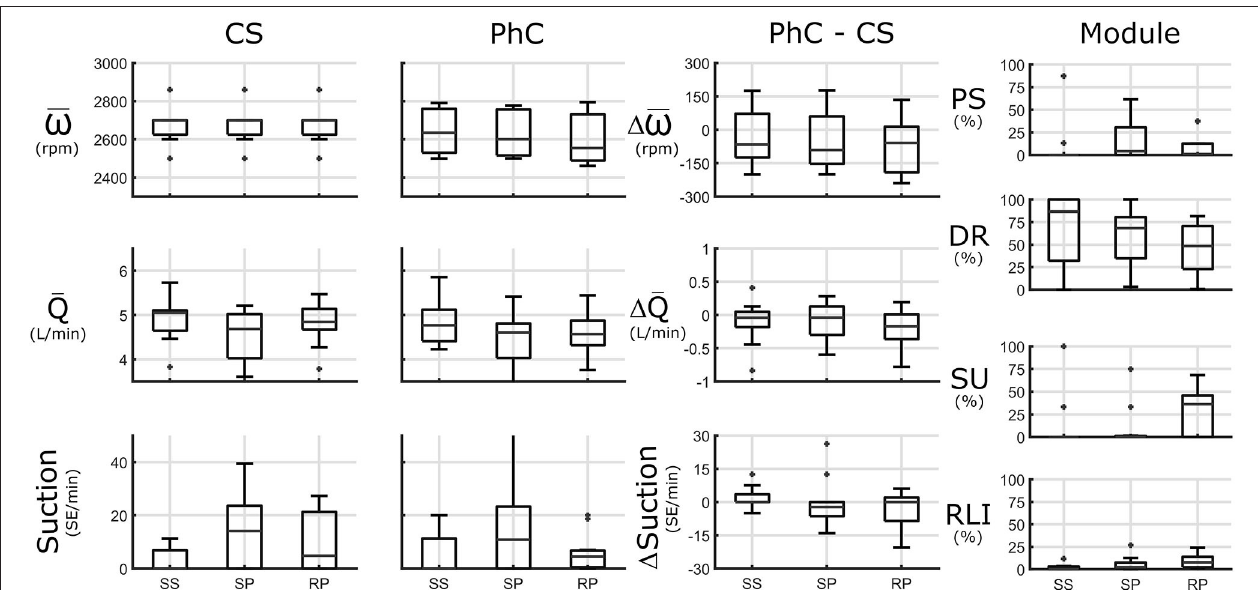
FIGURE 5 | Valsalva maneuver (VA) is subdivided into 3 phases: steady state (SS), strain phase (SP) and recovery phase (RP). Left panels: Speed ( ω ), flowrate (Q), and suction [in Suction Events (SE)/minute] in constant speed (CS) and physiologic control (PhC) and their differences are presented. Module panel: control module activation: activation for pulsatility (PS), demand response (DR), suction response (SU), and rate limited increase (RLI) modules. Speed is reduced in PhC compared to CS, resulting in lower suction burden.